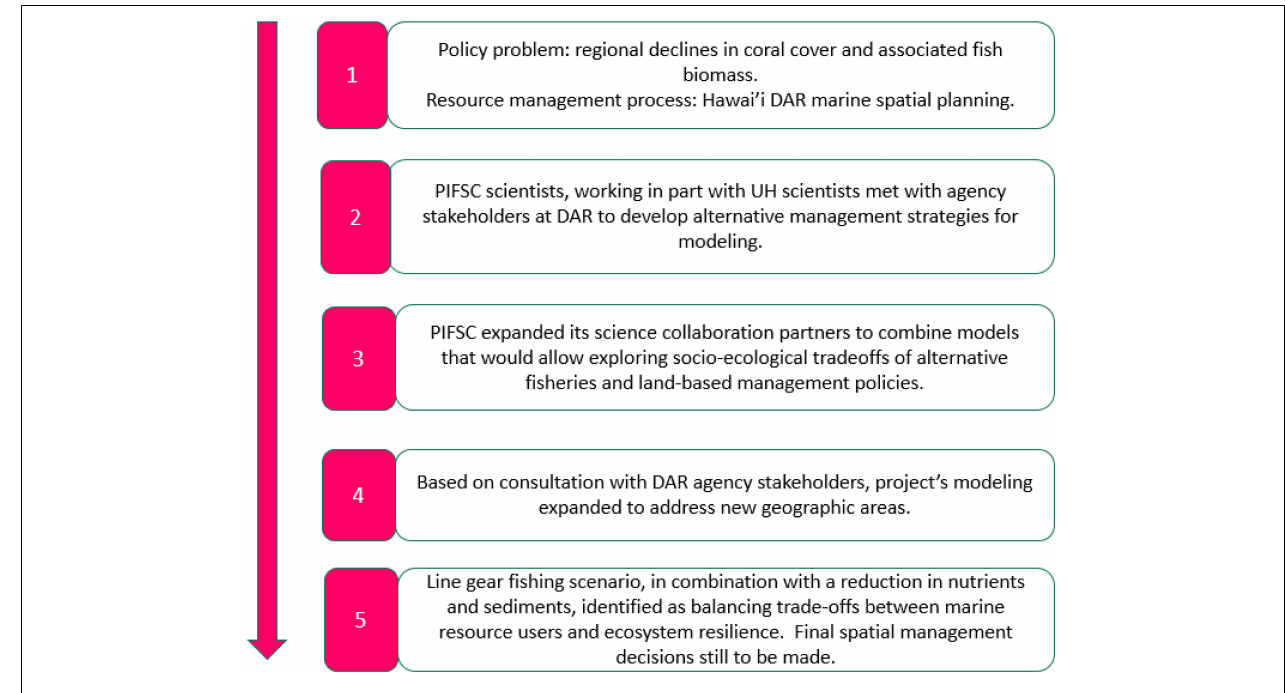
FIGURE 6 | Hawai’i Coral Reef Planning Case Study Process.